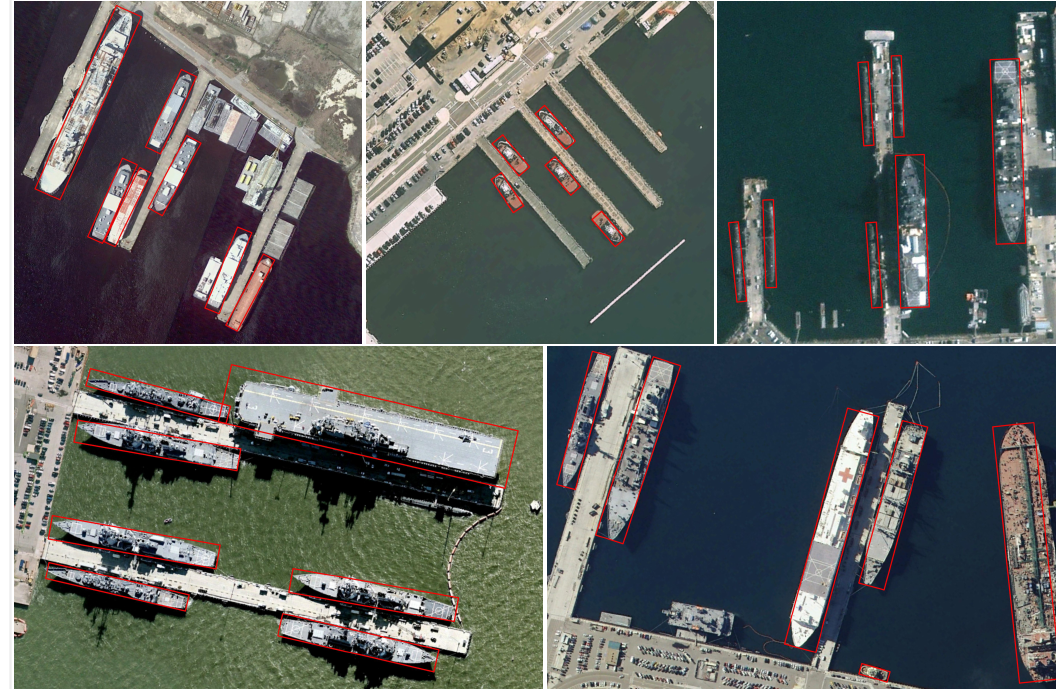
Figure 9. Visualization of detection results on HRSC2016.